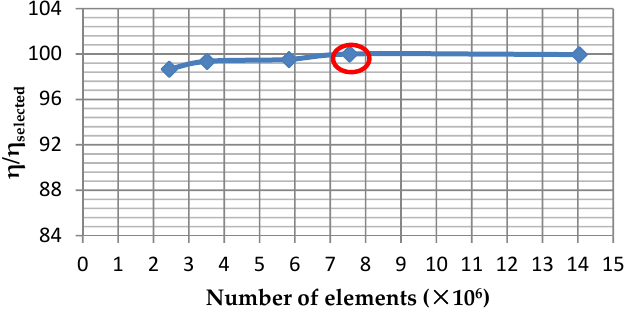
Figure 10. Mesh dependence for the full domain calculation.